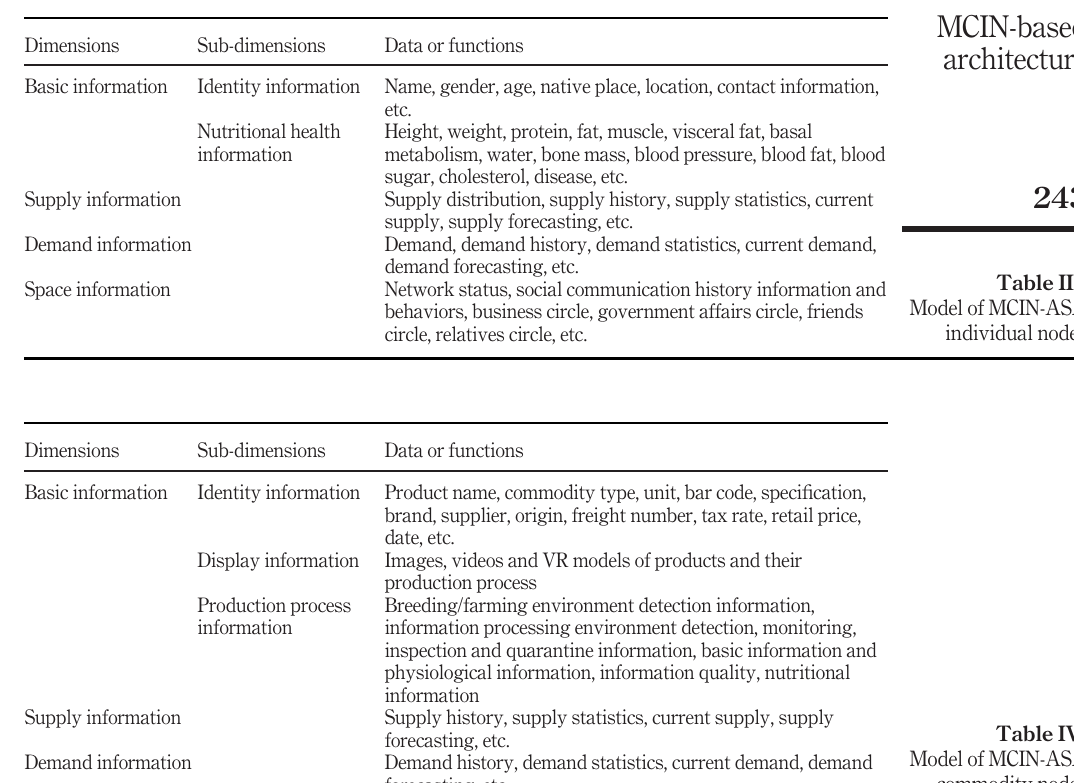
Table IV. Model of MCIN-ASA